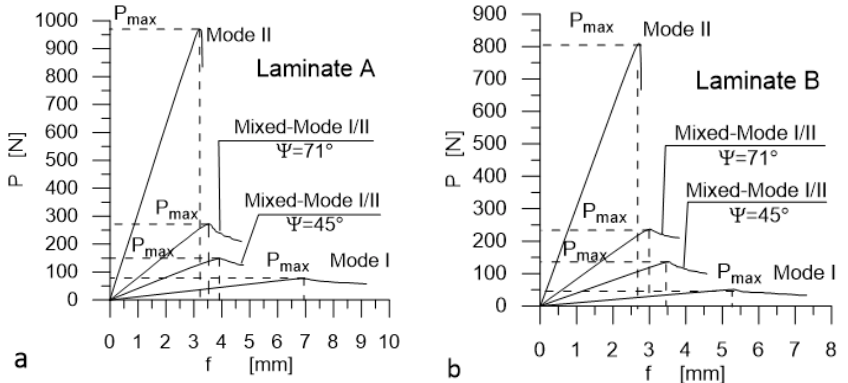
Figure 12. Examples of typical load–displacement plots; ( a ) for Laminate A and ( b ) for Laminate B.